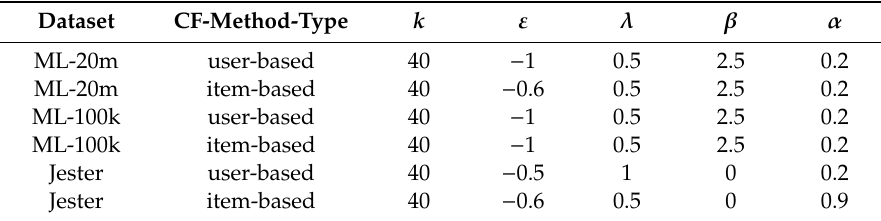
Table 2. Parameter settings used for evaluation. CF—collaborative